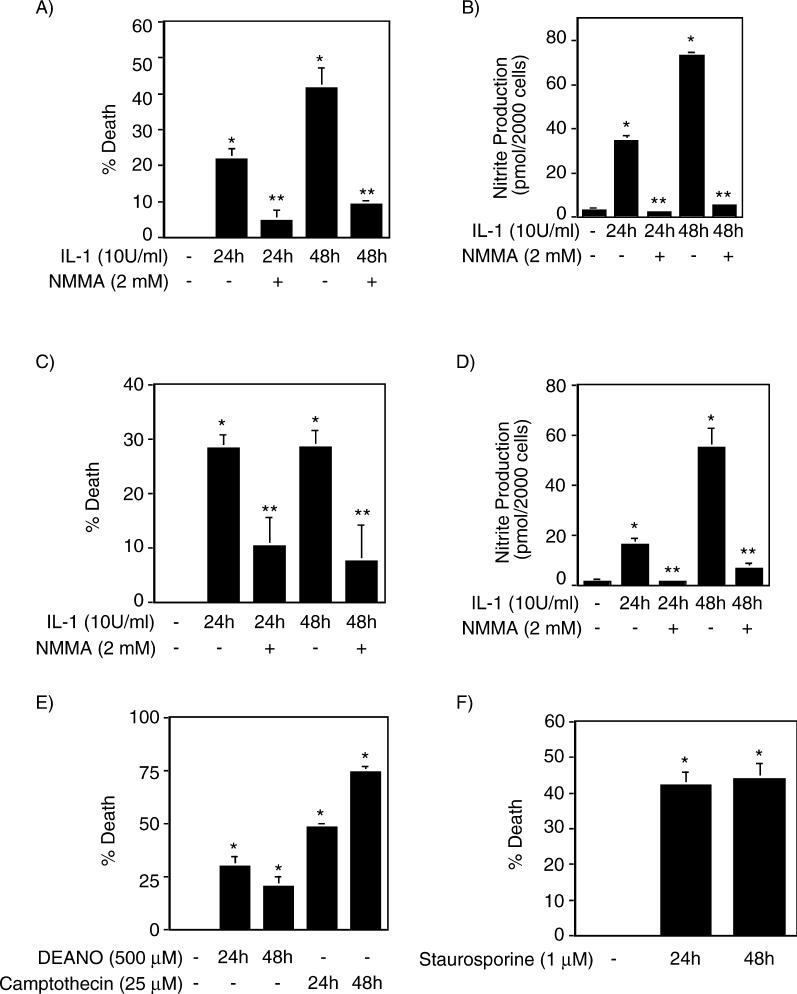
Nitric Oxide Mediates IL-1-Induced β-Cell Death as Determined by the MTT AssayRINm5F cells (A and B) or rat islets (C and D) were treated with IL-1 (10 units/ml) and NMMA (2 mM) for either 24 or 48 h, as indicated. The cells were isolated and viability determined using the MTT assay (A and C). The culture supernatants were isolated and nitrite production was determined using the Griess assay (B and D).(E and F) The effects of exogenously produced nitric oxide supplied by the donor compound DEANO (500 μM) and the apoptosis inducer camptothecin (25 μM) on RINm5F cell viability (E) and the apoptosis inducer staurosporine on rat islet cell viability (F) were determined by MTT assay.Cell viability data is expressed as percent death. Results for cell viability and nitrite production are the average ± standard error of the mean (SEM) of three independent experiments. *p < 0.05, significantly different from untreated controls. **p < 0.05, significantly different from IL-1-treated condition.